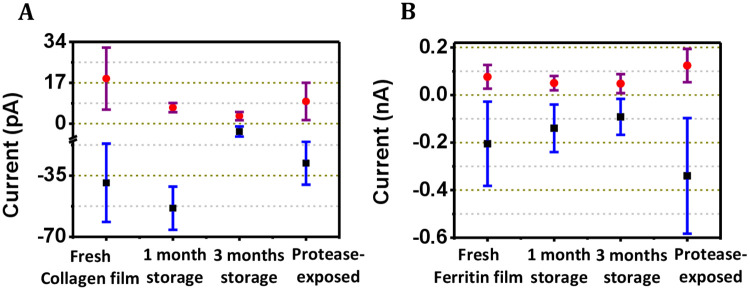
Data variability of the current values for proteins at the different storage conditions.For (A) collagen and (B) ferritin proteins, the variations represented by the purple lines and the blue lines are obtained from the current data points above the zero line and below the zero line, respectively, in the I-V curves.